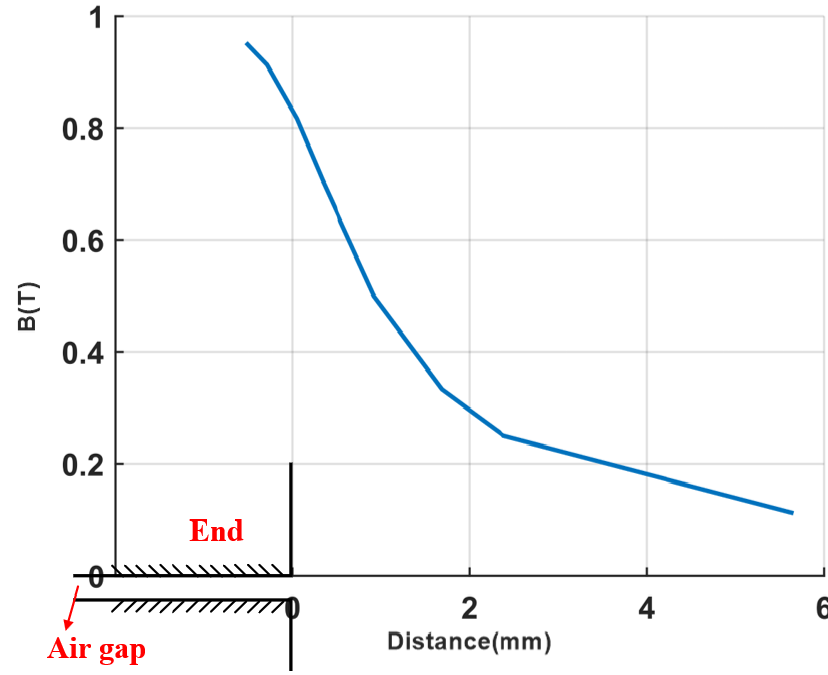
Figure 8. Distribution of air-gap magnetic field density at the UP-LPST end. The relative permeability distribution function of the primary side considering the end effect could be obtained by fitting the curve in Figure